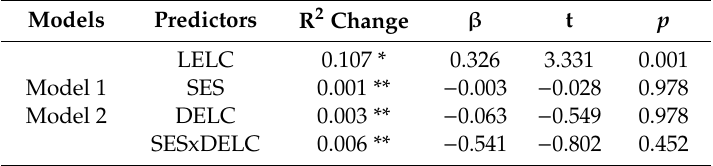
Table 10. Results of the hierarchical regression analyses on shifting (DCCS). R 2 = 0.11.